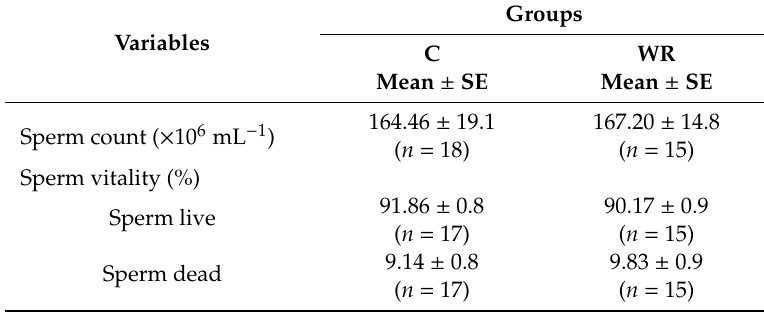
Table 5. Sperm parameters of F1 male o ff spring of control or water-restricted